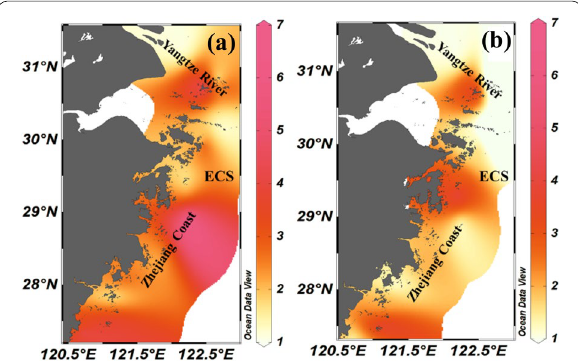
Fig. 1 Bloom frequency of a Prorocentrum donghaiense and b Karenia mikimotoi in East China Sea (ECS) during 2004–2020. Bloom occurrence data of P. donghaiense and K. mikimotoi were collected from the State Ocean Administration (SOA) and the Bulletin of